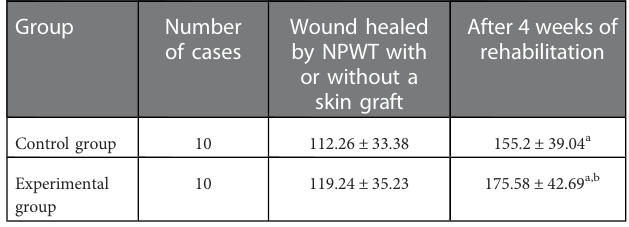
TABLE 1 Comparison of TAM scores between the two groups ð (cid:1) x + s Þ .